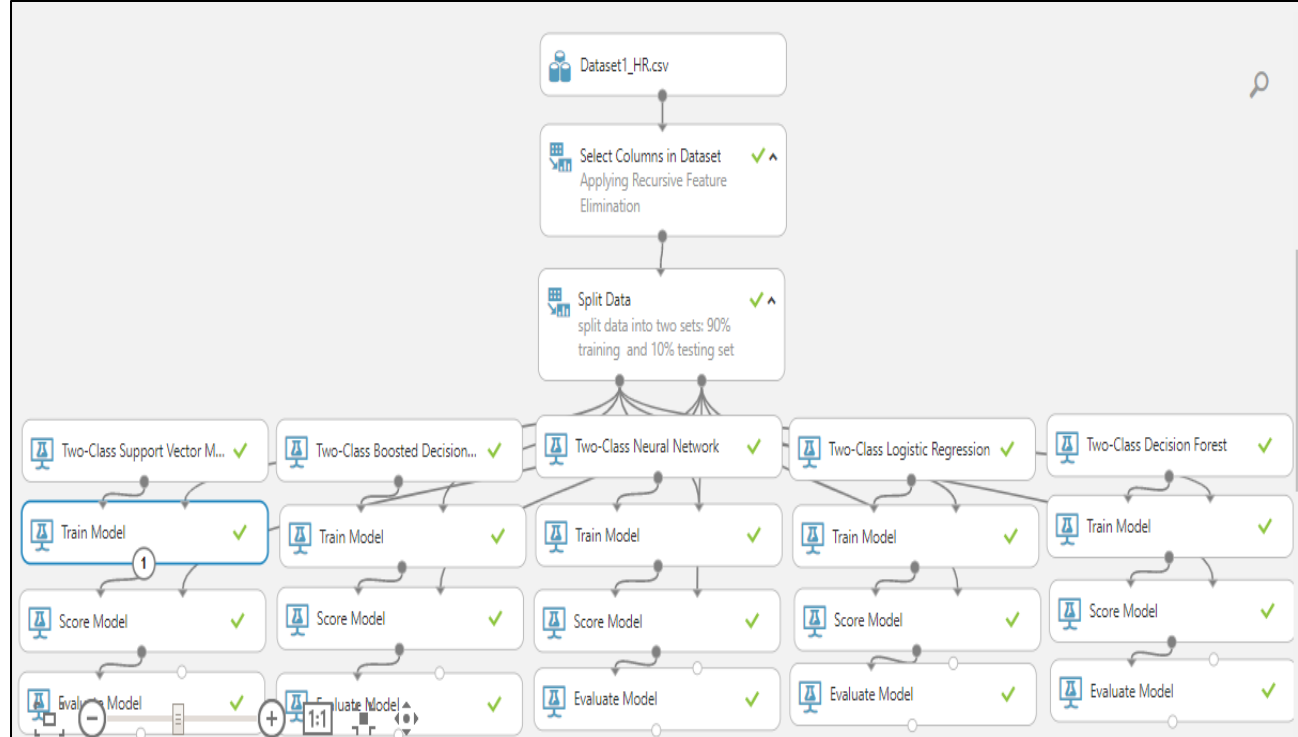
Figure 18. Comparison of RFE successful execution with the proposed model.